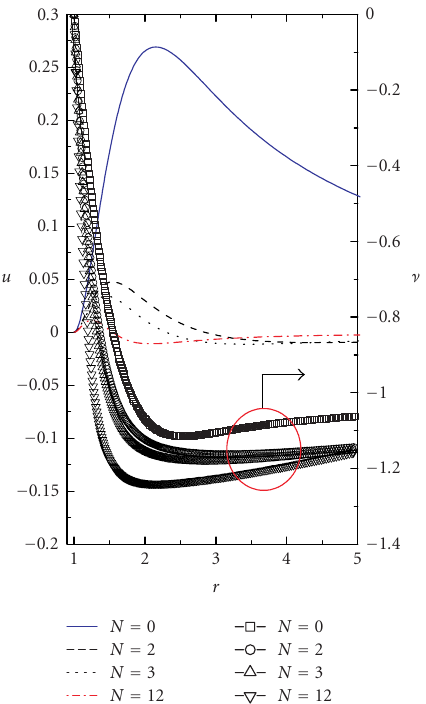
Figure 4.12 . Variation of radial u and transverse v components of velocity U of the flow with Re = 20. Lines without symbol represent radial velocity with left y -axis. The lines with symbol represent the transverse velocity with right y -axis.